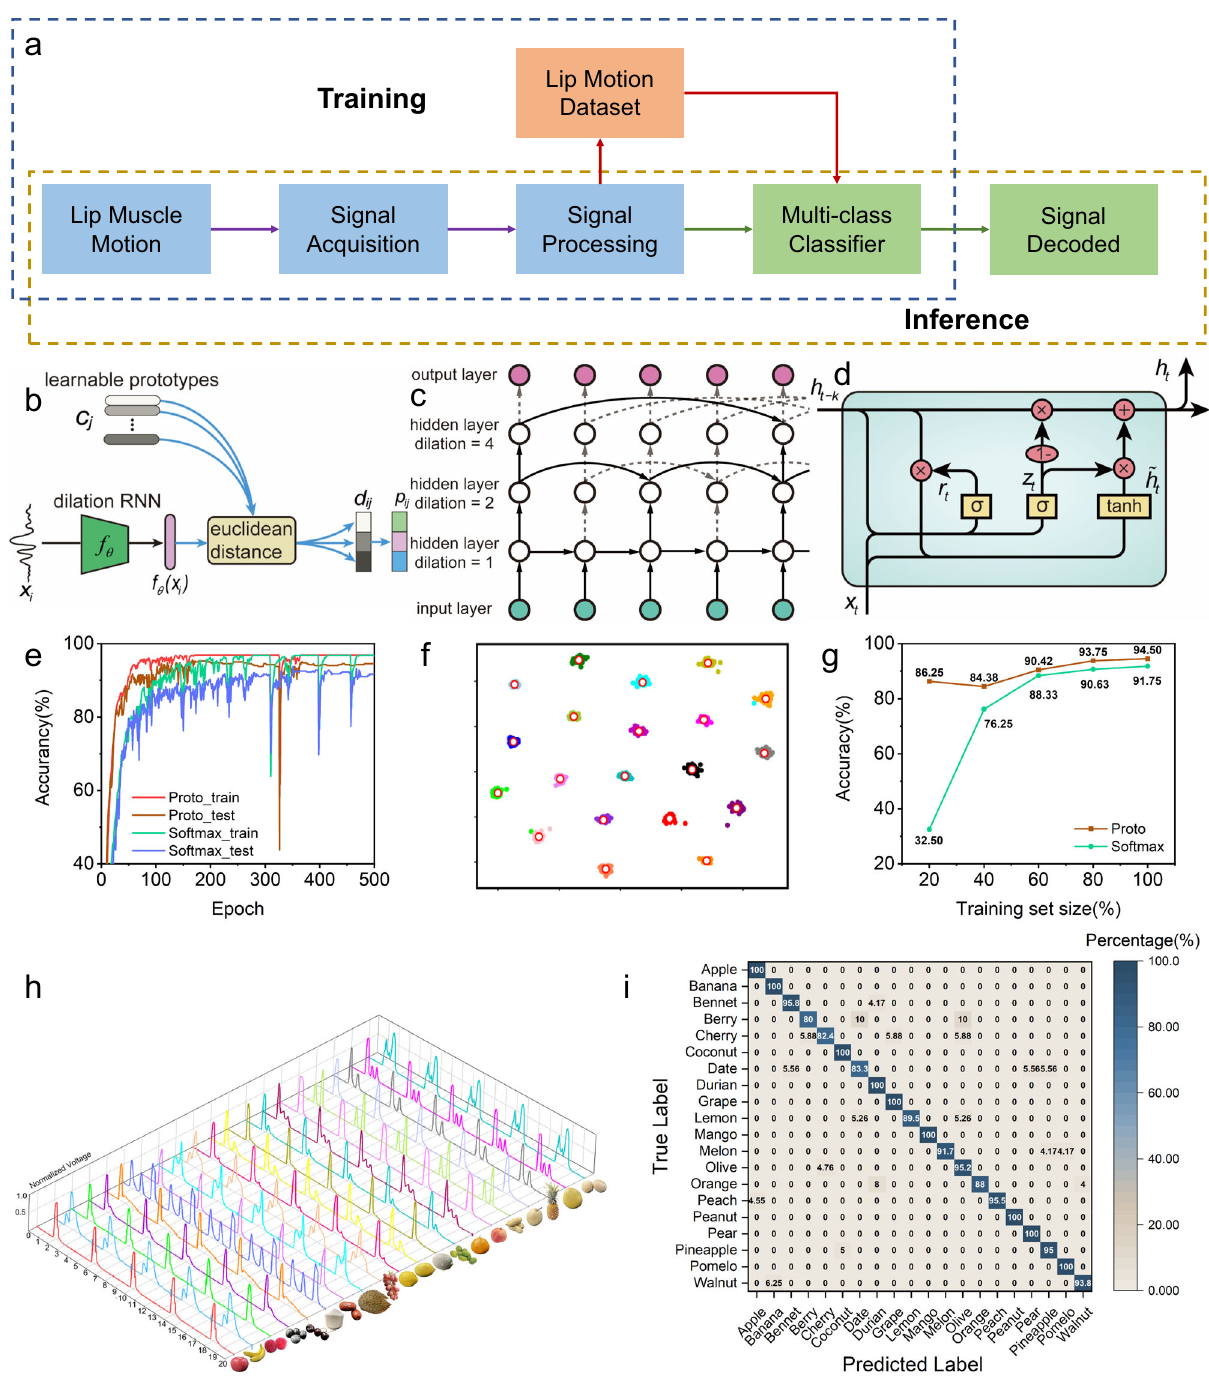
Fig. 4 A signal classi fi cation experiment based on deep learning. a Deep learning aided data process fl ow, including a training and an inference process. b Schematic diagram of the overall structure of the dilated recurrent neural network model based on prototype learning. c Structure diagram of the feature extractor in the model. d The basic unit of the dilated recurrent neural network GRU. e The training and testing accuracy curves obtained during the learning process for the dilated recurrent neural network based on the softmax-classi fi cation layer and prototype learning. f Visualization of the two- dimensional features of the dilated recurrent neural network based on prototype learning. g Comparison of the test accuracy for two models with different sample sizes. h 3D plot of the lip-motion signals generated for 20 spoken words (fruit) in the dataset. i The confusion matrix for lip-motion signals for